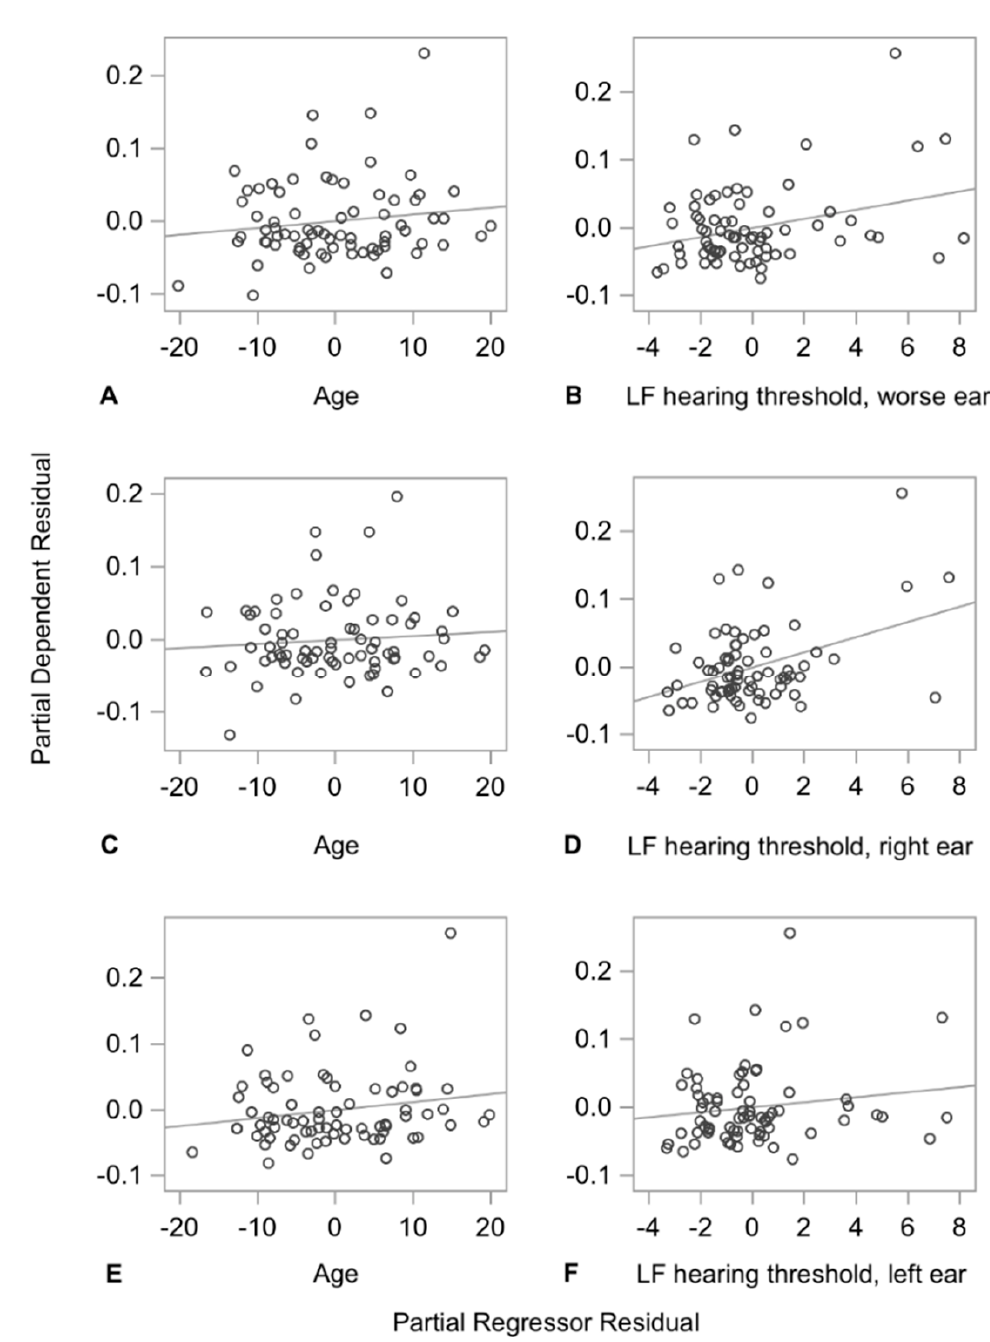
Figure 3. Partial regression plots for double support period (DSP) CV for age and low frequency hearing thresholds for the poorer hearing ear, the right ear, and the left ear. Each plot illustrates the strength of the relationship between DSP CV and age ( A , C , E ), or low frequency hearing thresholds of the poorer hearing ear ( B ), the right ear ( D ), or the left ear ( F ). There is a strong positive relationship between variability in DSP and low frequency hearing thresholds for the poorer hearing ear and the right ear, respectively. LF indicates low frequency.